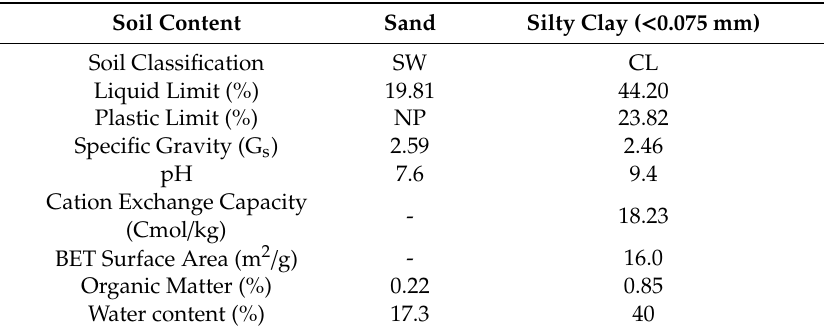
Table 1. Material properties of soils.